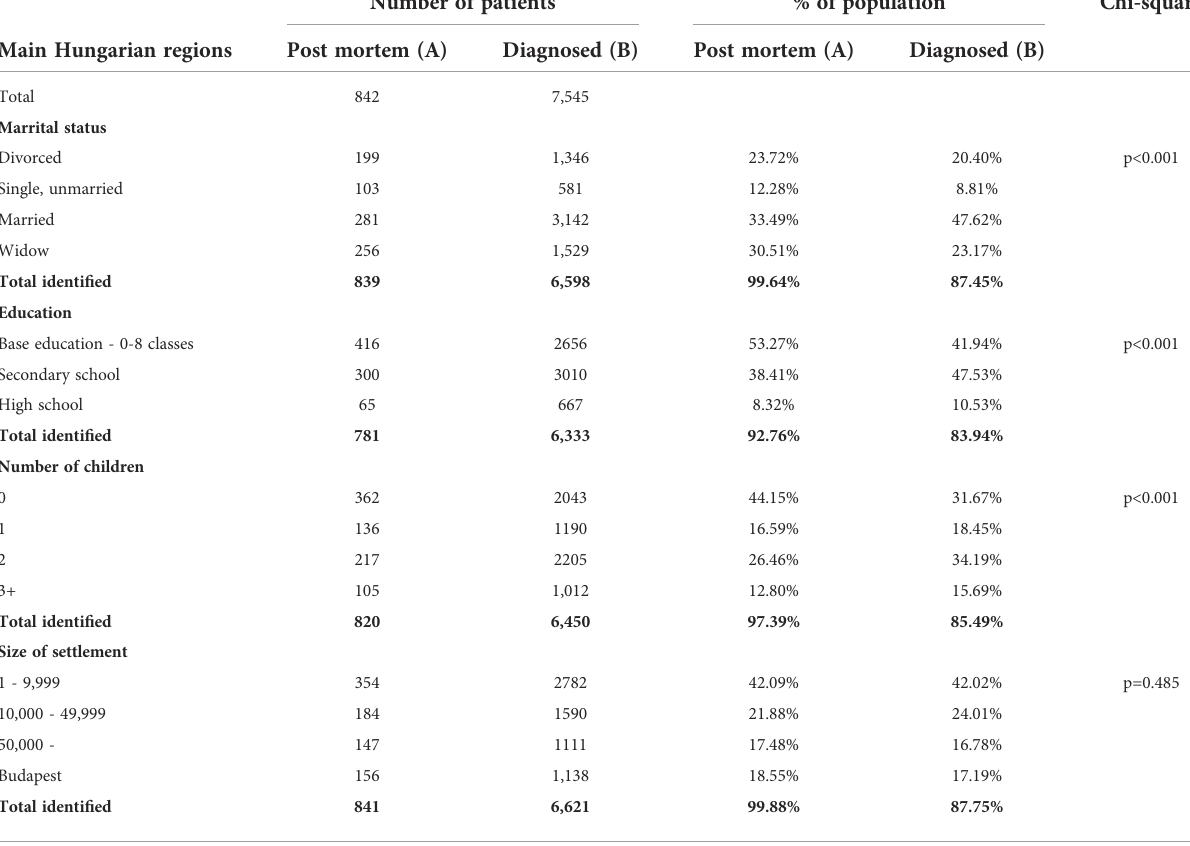
TABLE 2 Socio-economic status of Hungarian post-mortem diagnosed LC patients and patients who were and diagnosed while still